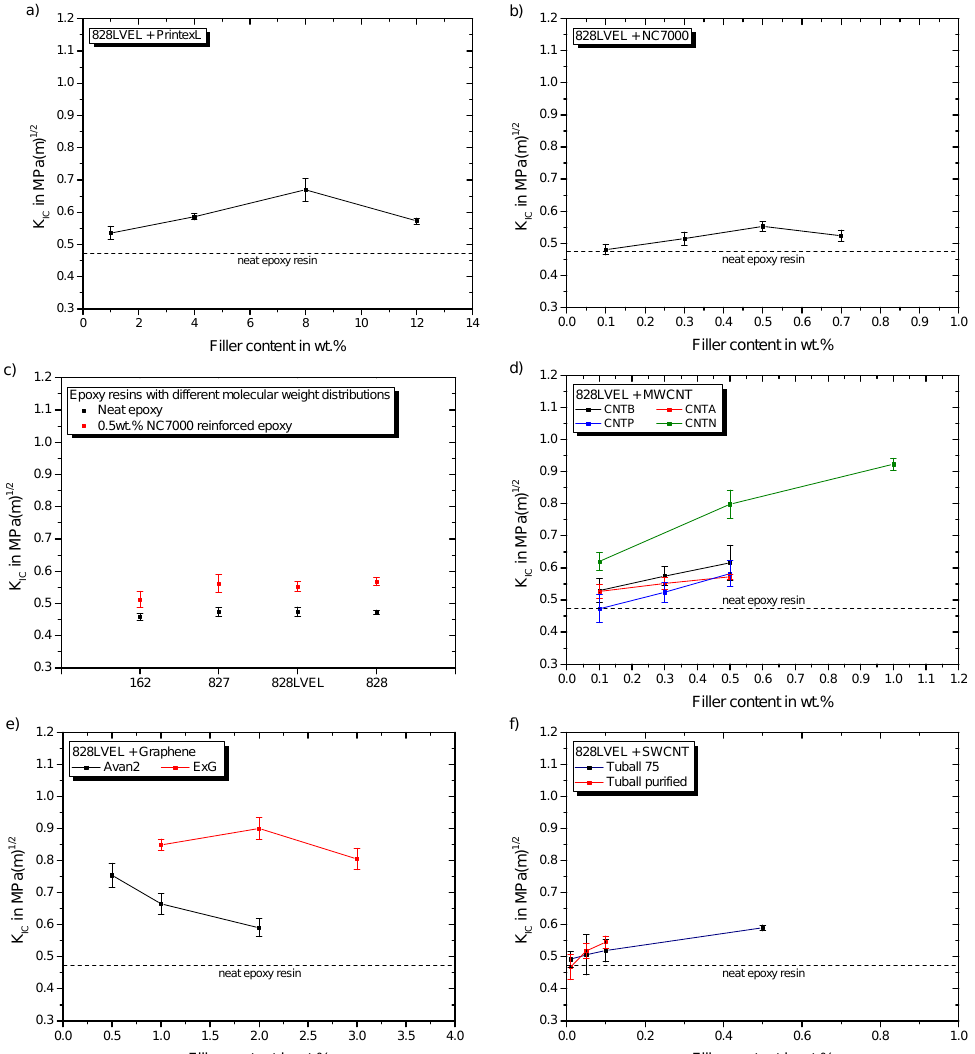
Figure 14. Particles impact on fracture toughness in mode I for ( a ) CB in Epikote 828LVEL ( b ) NC7000 in Epikote 828LVEL ( c ) 0.5wt.% NC7000 in Epikote 162, 827, 828LVEL, and 828 ( d ) CNTB, CNTA, CNTP and CNTN in Epikote 828LVEL ( e ) Avan2 and ExG in Epikote 828LVEL ( f ) Tuball 75 and Tuball purified in Epikote